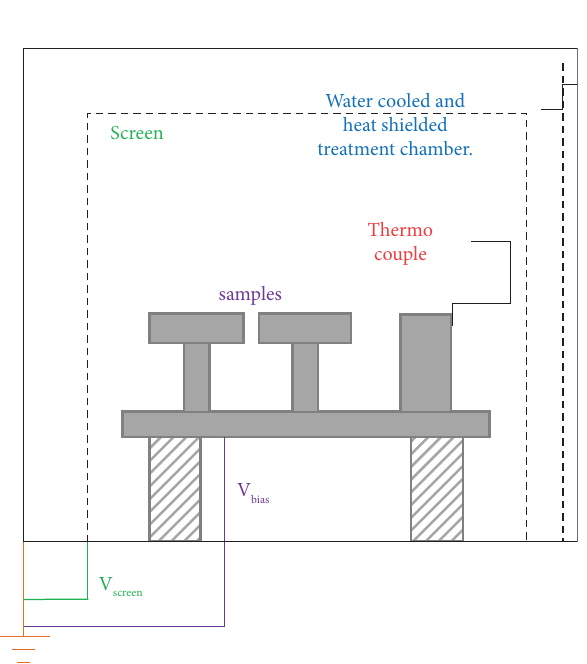
Figure 12: Scheme of the active screen plasma nitriding